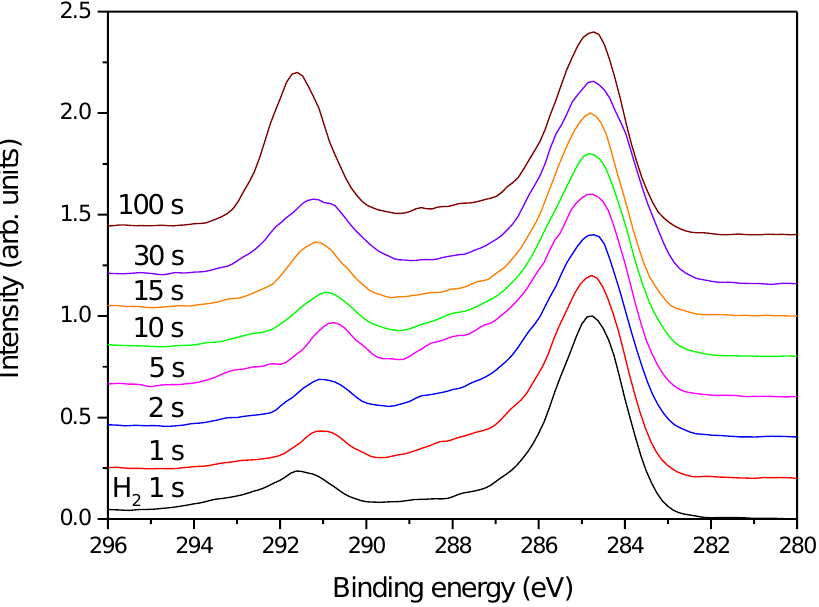
Figure 9. The high-resolution C1s spectra for samples treated at different times in ammonia plasma in the continuous mode at the power of 200 W.